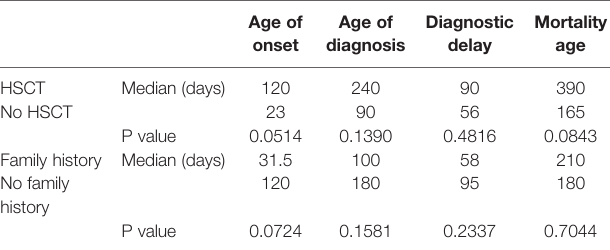
TABLE 1 | Medians and P values (P < 0.05, CI 95%) for age of onset, age of diagnosis, diagnostic delay, and mortality in relation to HSCT and family history of SCID.